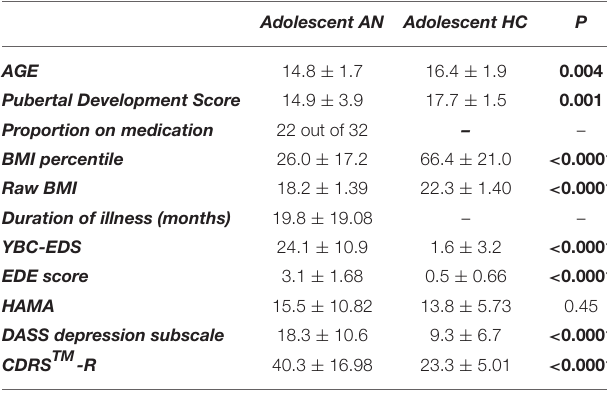
TABLE 1 | Demographic and clinical characteristics of patients with AN and control subjects. Adolescent AN Adolescent